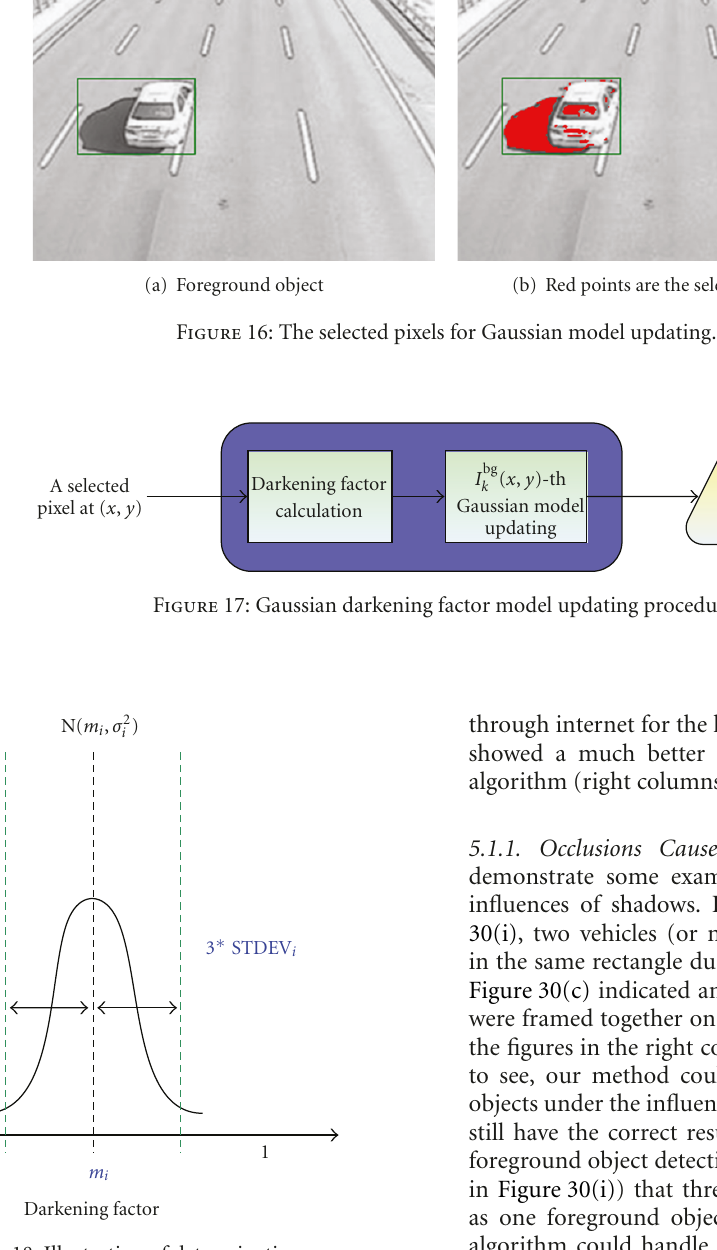
Figure 18: Illustration of